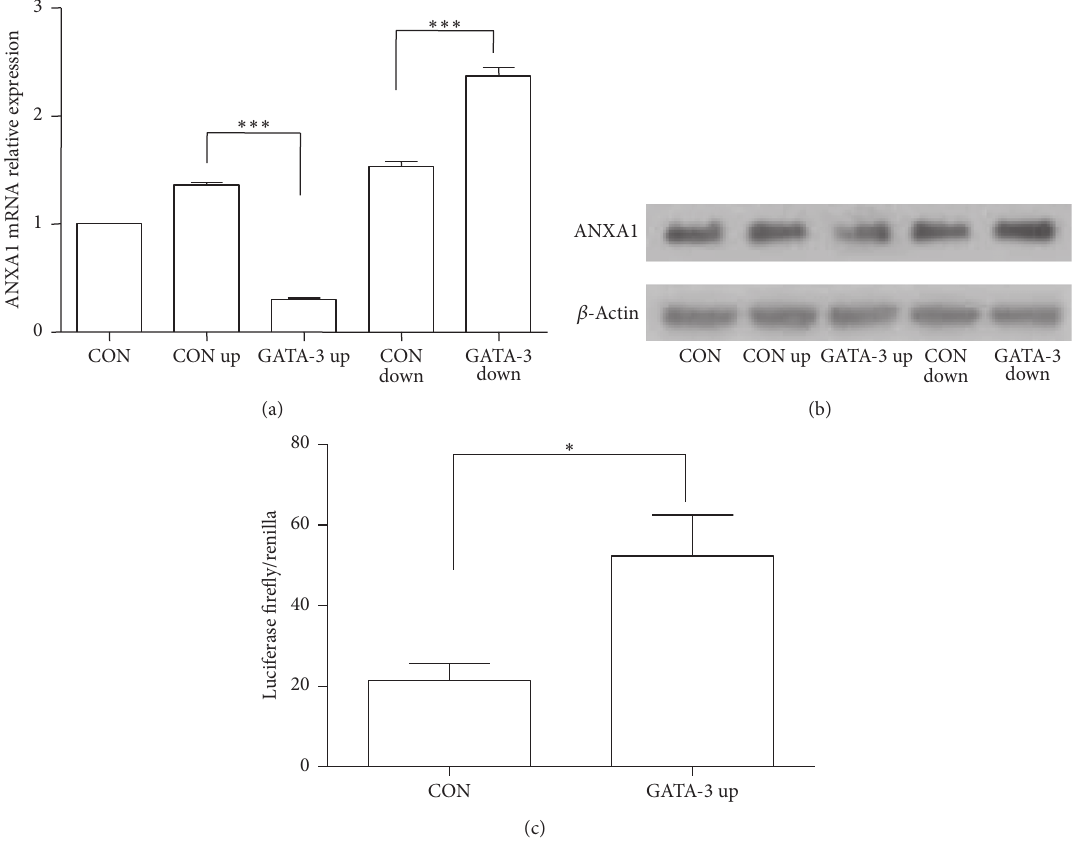
Figure 5: GATA-3 modulates ANXA1 expression in Th0 conditions. CD4 + T cells were infected with GATA-3 up or GATA-3 down Lentivirus in Th0 condition and then stimulated with anti-CD3/CD28 (5.0 𝜇 g/mL) for 8 h to analyze ANXA1 expression by real-time PCR (a) and western bolt (b). Dual luciferase assays showed an increase after transfection of GATA-3 in 293T cells (c). ∗ 𝑝 < 0.05 . ∗∗∗ 𝑝 < 0.001 .